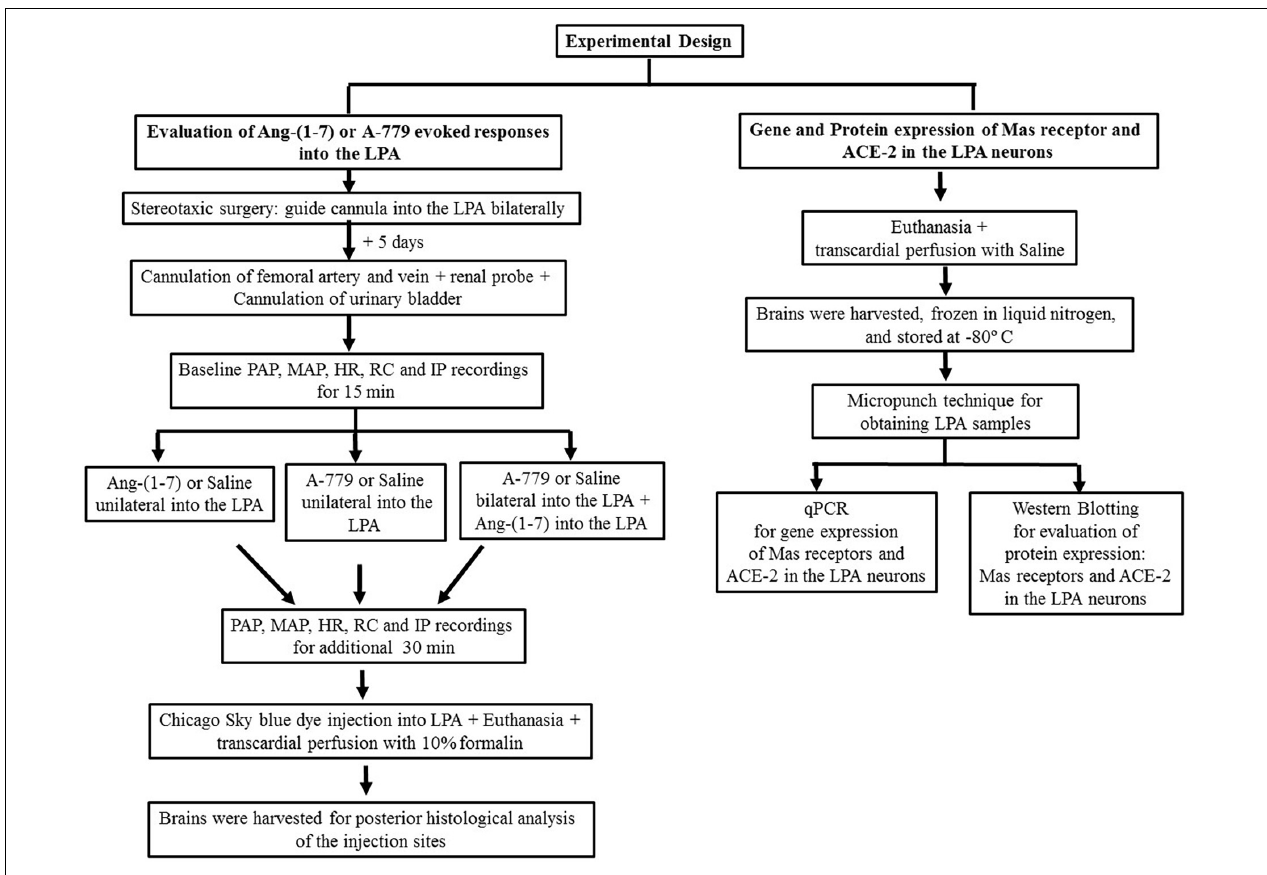
FIGURE 1 | A flowchart depicting the experimental design details.